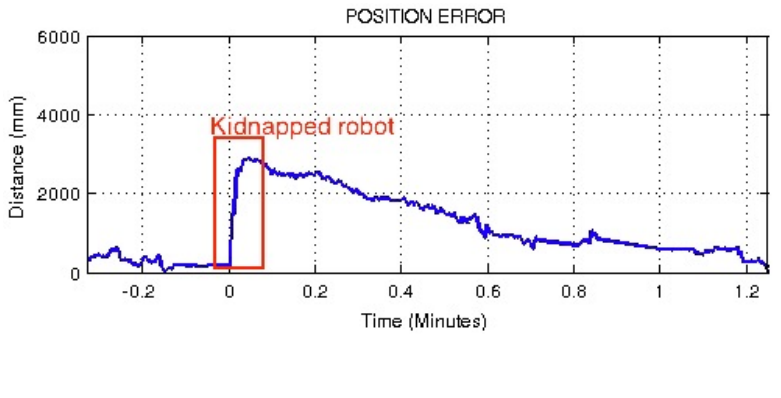
Figure 24. Results of the ‘kidnapped robot’ test using the classical resampling